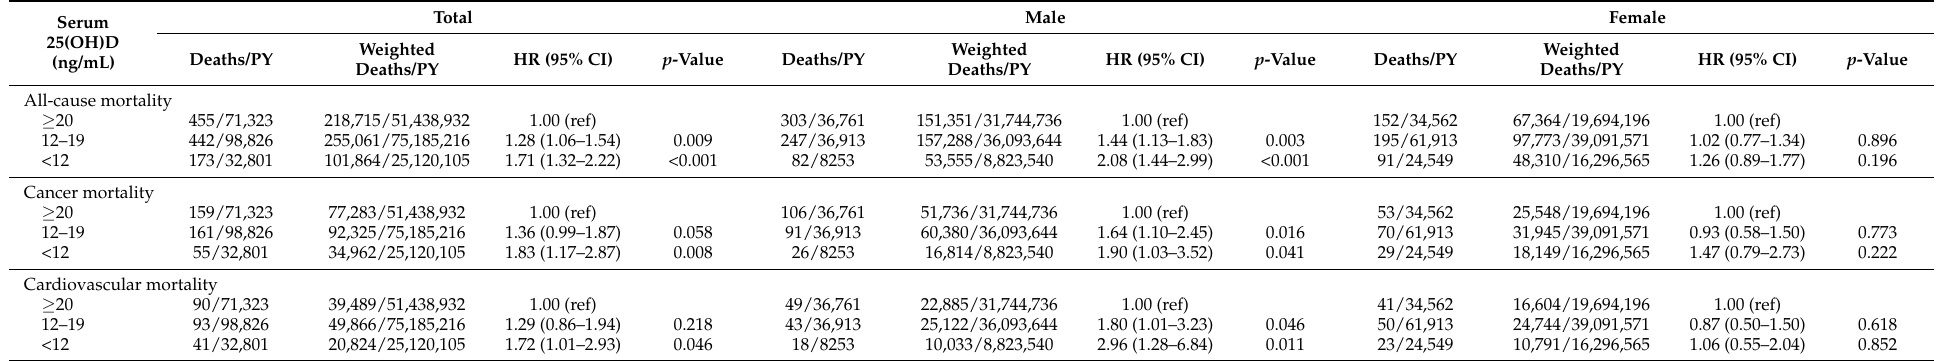
Table 2. Multivariable-adjusted hazard ratios (HRs) and 95% confidence intervals (CIs) for the association of serum 25(OH)D with all-cause mortality and cause-specific mortality, stratified by sex.